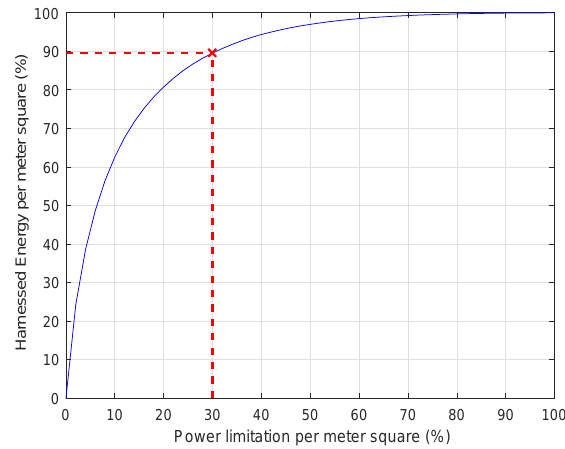
Figure 9. Harnessed energy rate versus power limitation